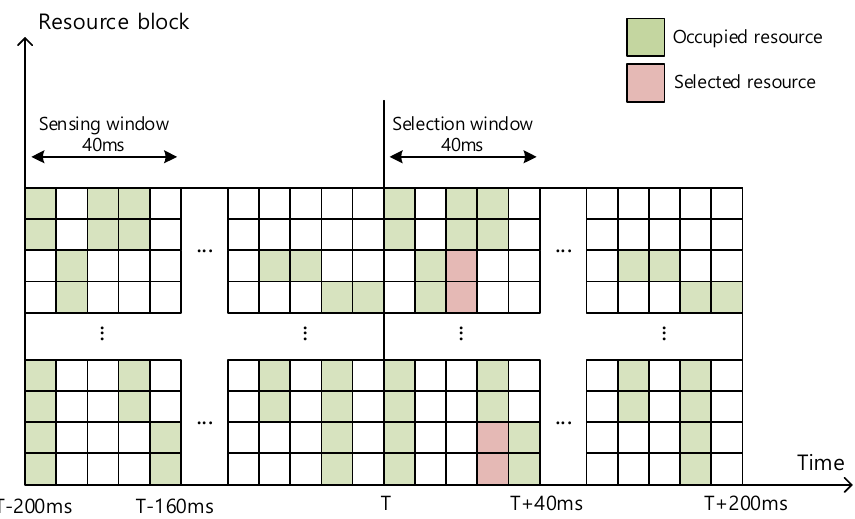
Figure 2. Partial sensing window and selection window.